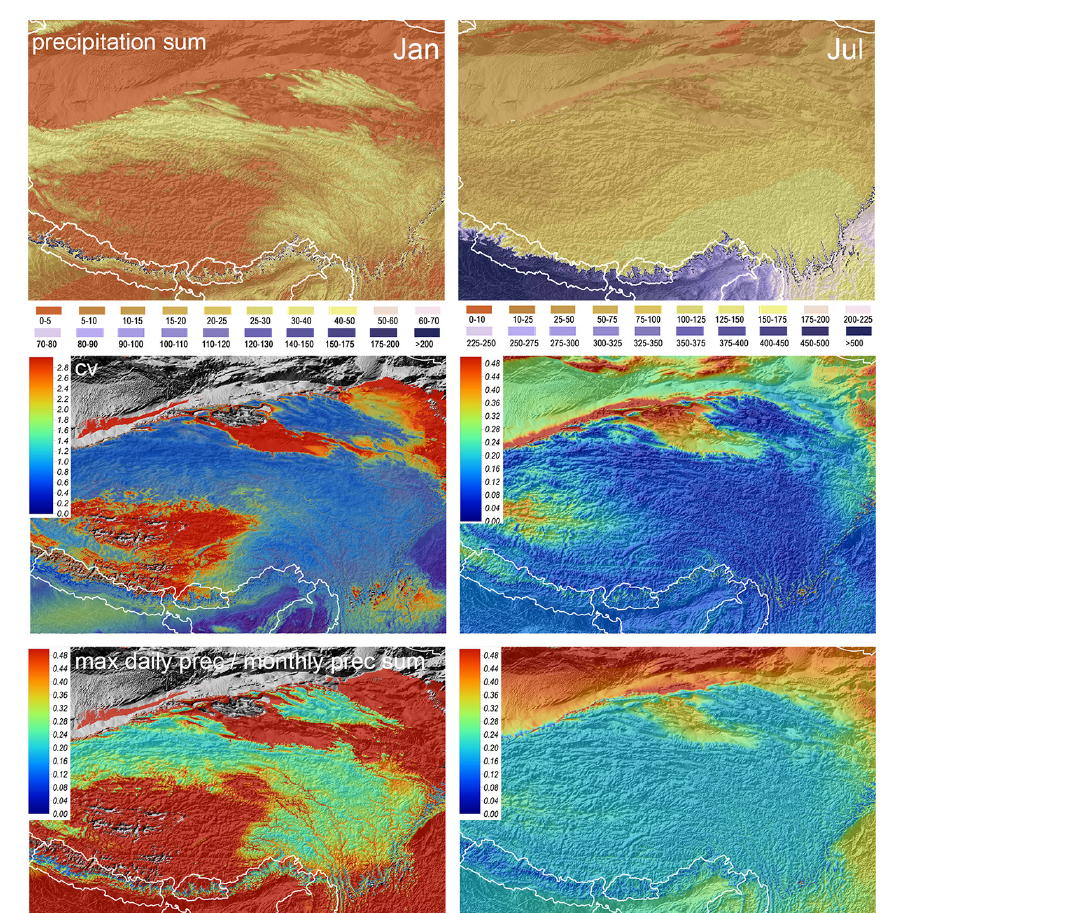
Figure 7. Mean monthly precipitation sum [mm] (top panels), coefficient of variation (middle panels) and the ratio of maximum daily precipitation and the monthly sum (bottom panels) for January (left panels) and July (right